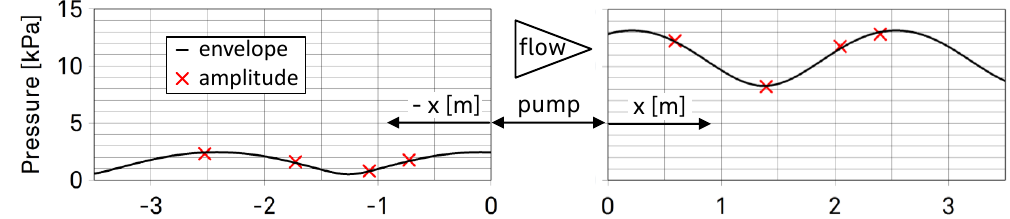
Figure 2. Measured and least-square fitted envelope of the pressure amplitudes ˆ p ( x n ) upstream and downstream of the pump as a function of location ( P 1 : n s = 25 1 f BP = 290